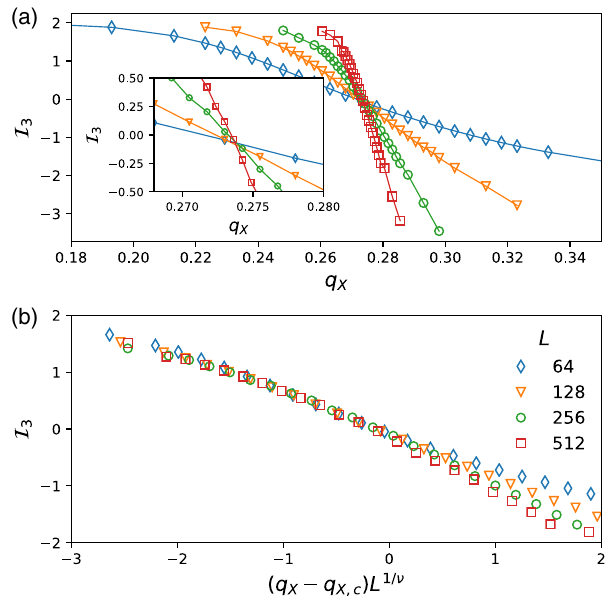
FIG. 5. Entanglement transition in the factorizable ensemble q ¼ ð 0 ; q ; 1 − q ; 0 Þ with range r ¼ 3 . Data obtained from X X numerical simulations with the stabilizer method, averaged over 10 2 to 10 4 realizations of the random dynamics (depending on L ). (a) Tripartite mutual information I 3 as a function of q . The X value I 3 ¼ 2 on the area-law side is due to the presence of two integrals of motion (bits of global entanglement). Different sizes 64 ≤ L ≤ 512 show a crossing at q 0 . 274 ð 2 Þ (inset). q X ¼ X;c ¼ (b) Scaling collapse of the data with exponent ν ¼ 1 . 1